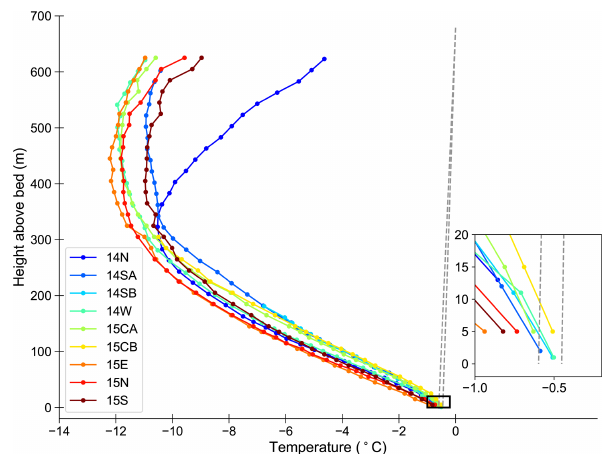
Figure 2. Temperature profiles for each borehole plotted with re- spect to each sensor’s height above the bed. Sensor locations are marked with points, and temperatures between sensors are linearly interpolated. Dashed lines indicate the range of pressure melting temperatures given the various Clausius–Clapeyron gradients pre- sented in Cuffey and Paterson (2010). The black box indicates the extent of the inset showing temperatures in the lowest